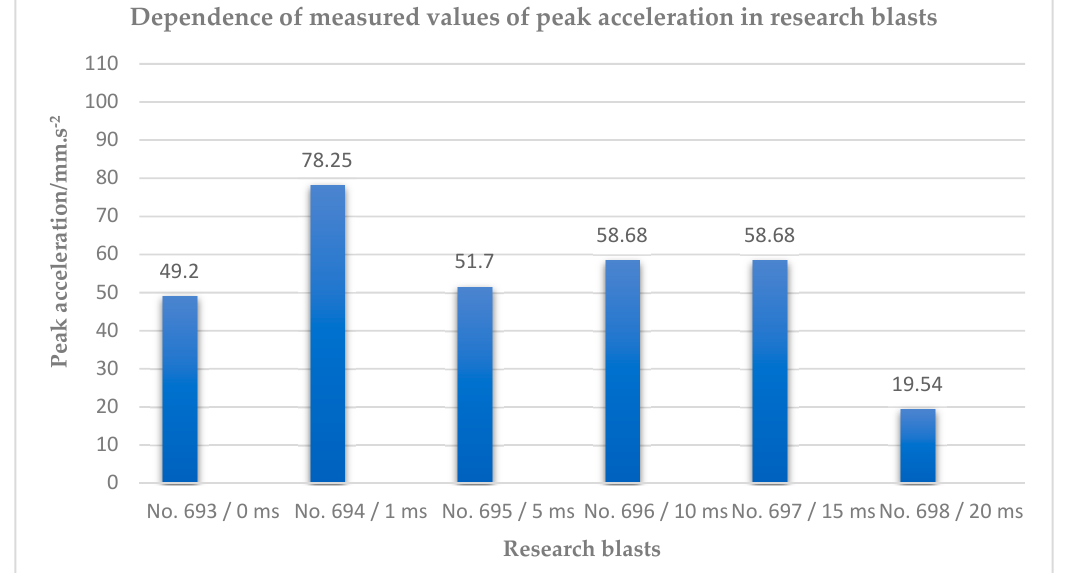
Figure 9. Dependence of measured values of peak acceleration in blasts (source: author).